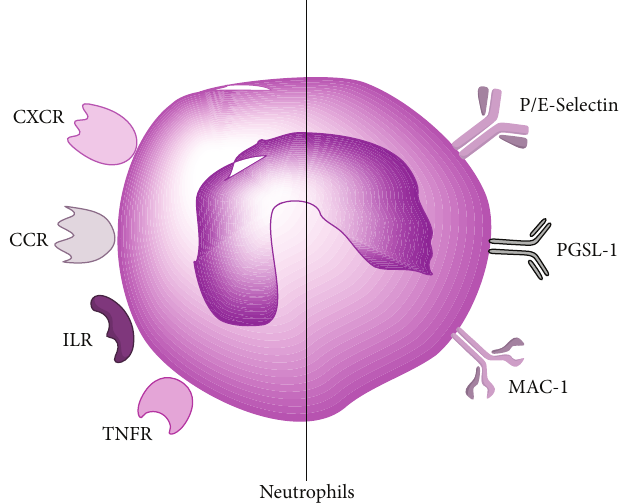
Figure 4: The receptors (the left) related to chemokines (CCR, CXCR) and cytokines (TNFR, ILR), and CAMs (the right) on